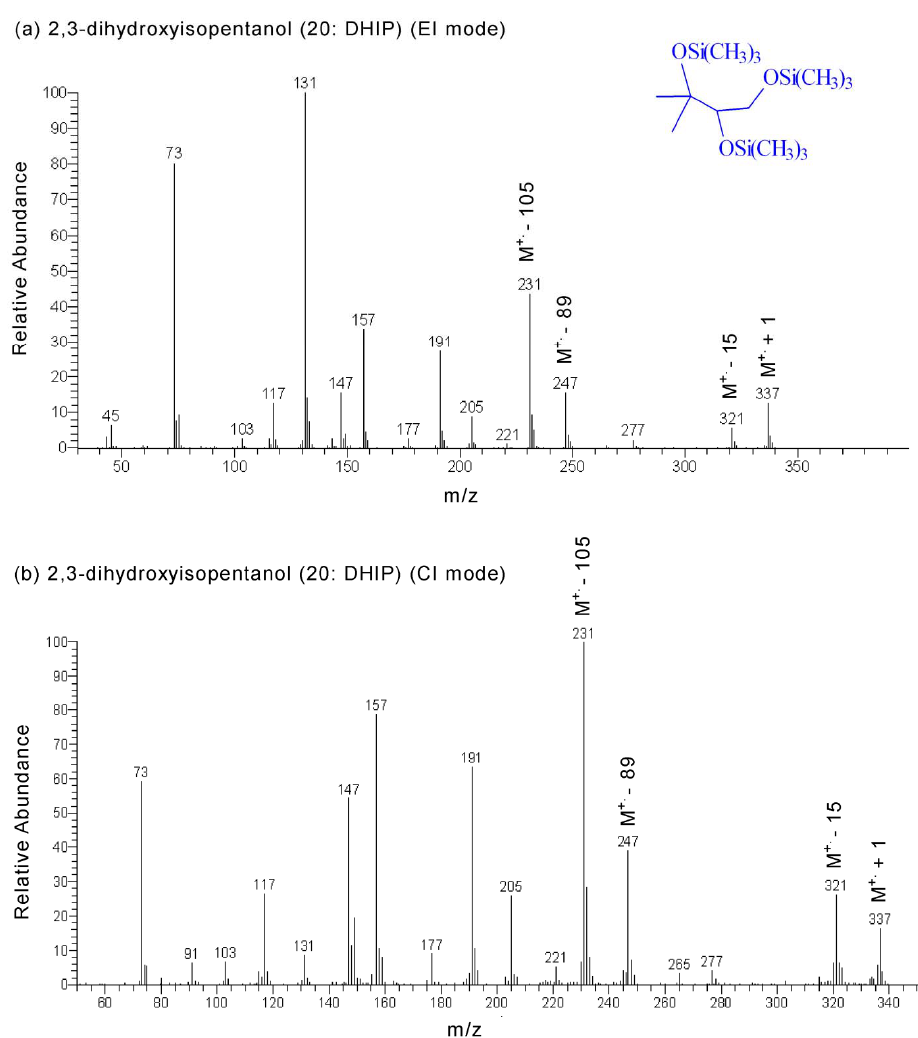
Fig. 4. EI (a) and CI (b) mass spectra of the BSTFA derivative of 2,3-dihydroxyisopentanol (20).